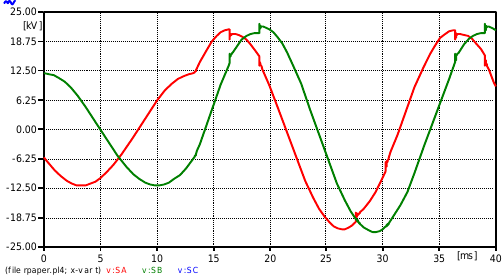
Fig. 9. Minimum resonance frequency for phase-c secondary to the base of cable length.